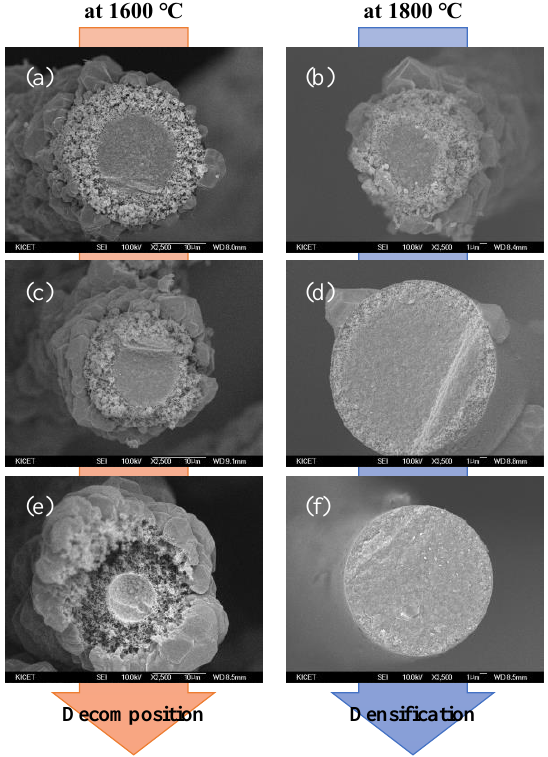
Figure 6. The cross-sectional SEM images of polycrystalline SiC fibers fabricated at 1600 and 1800 °C using fibers with controlled impurity content at 1400 °C for ( a , b ) 2, ( c , d ) 4, and ( e , f ) 6 h.